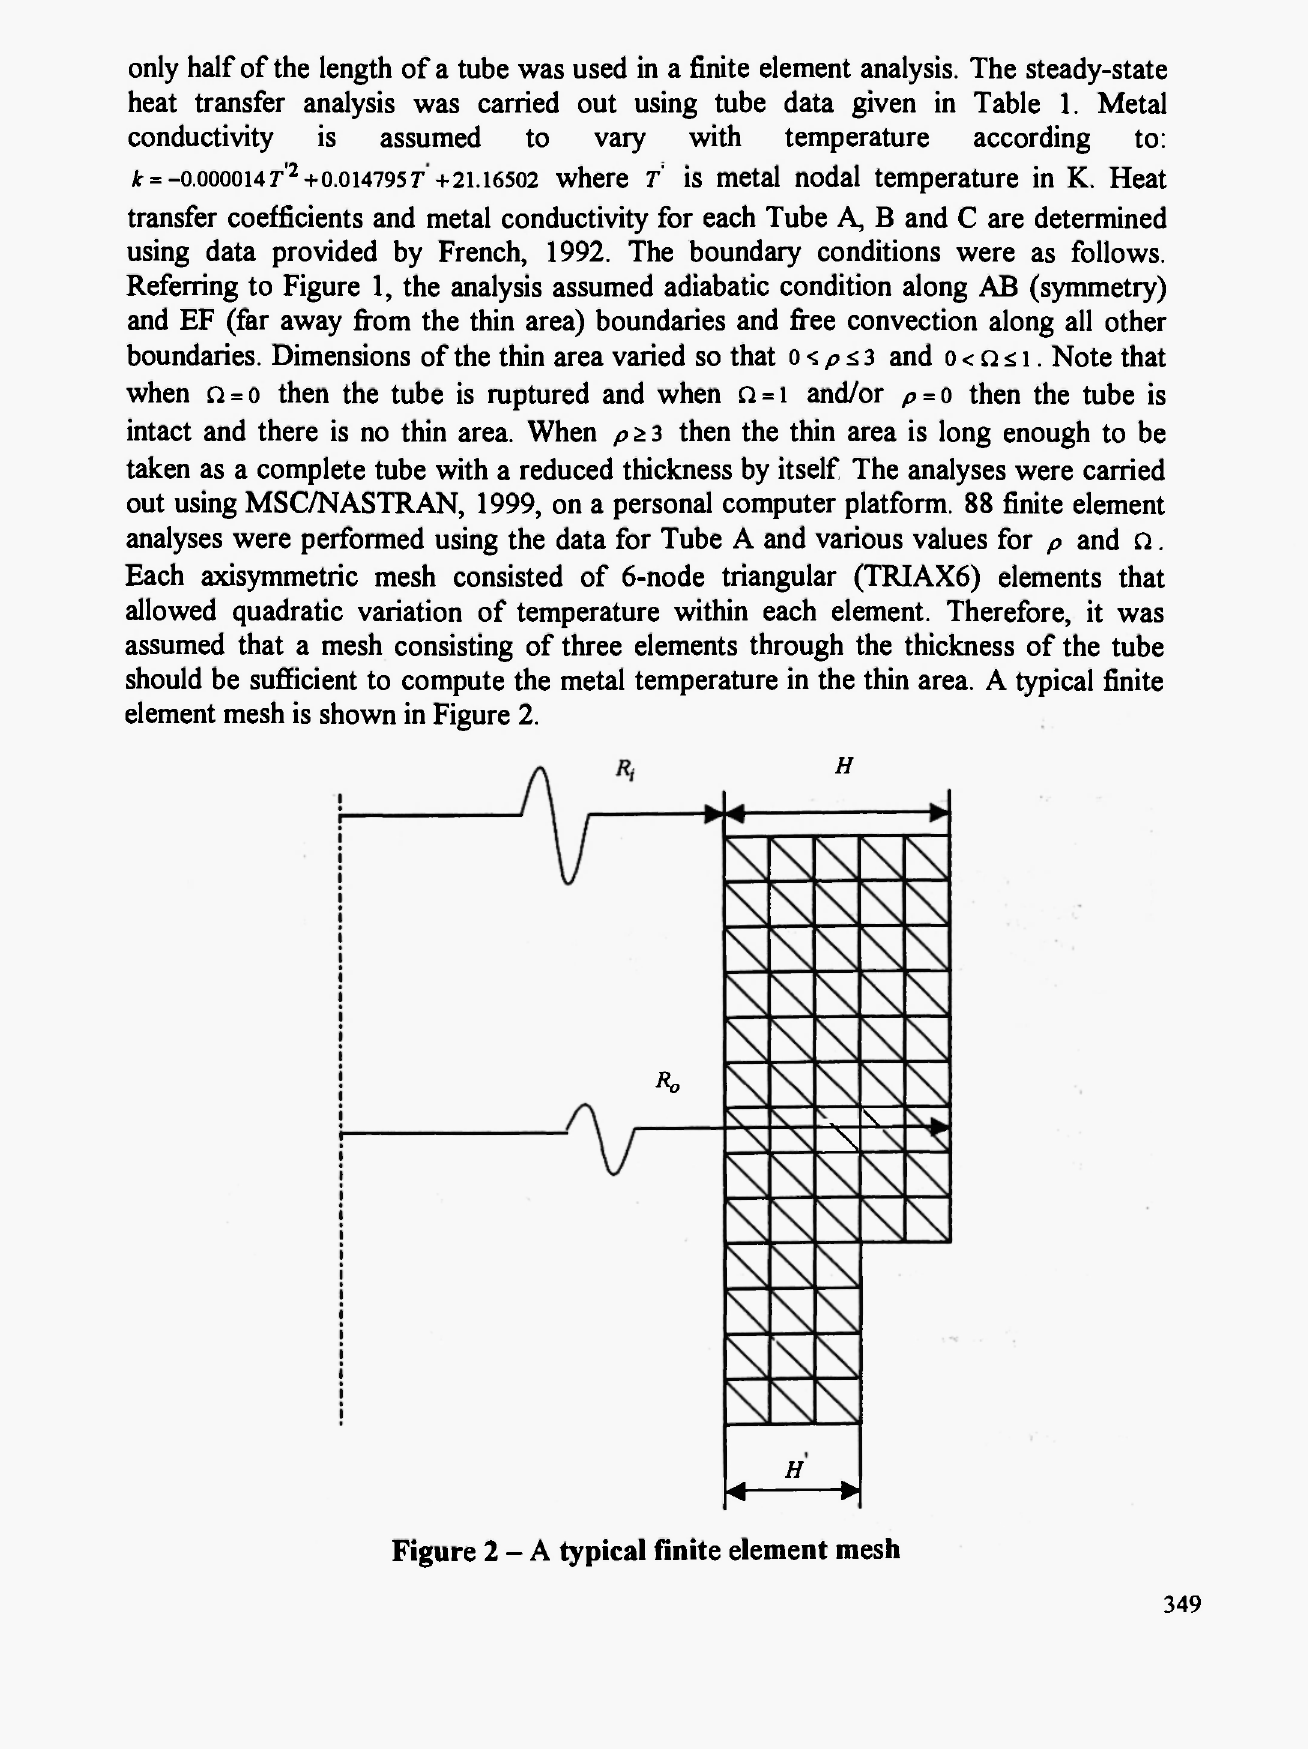
Figure 2 - A typical finite element